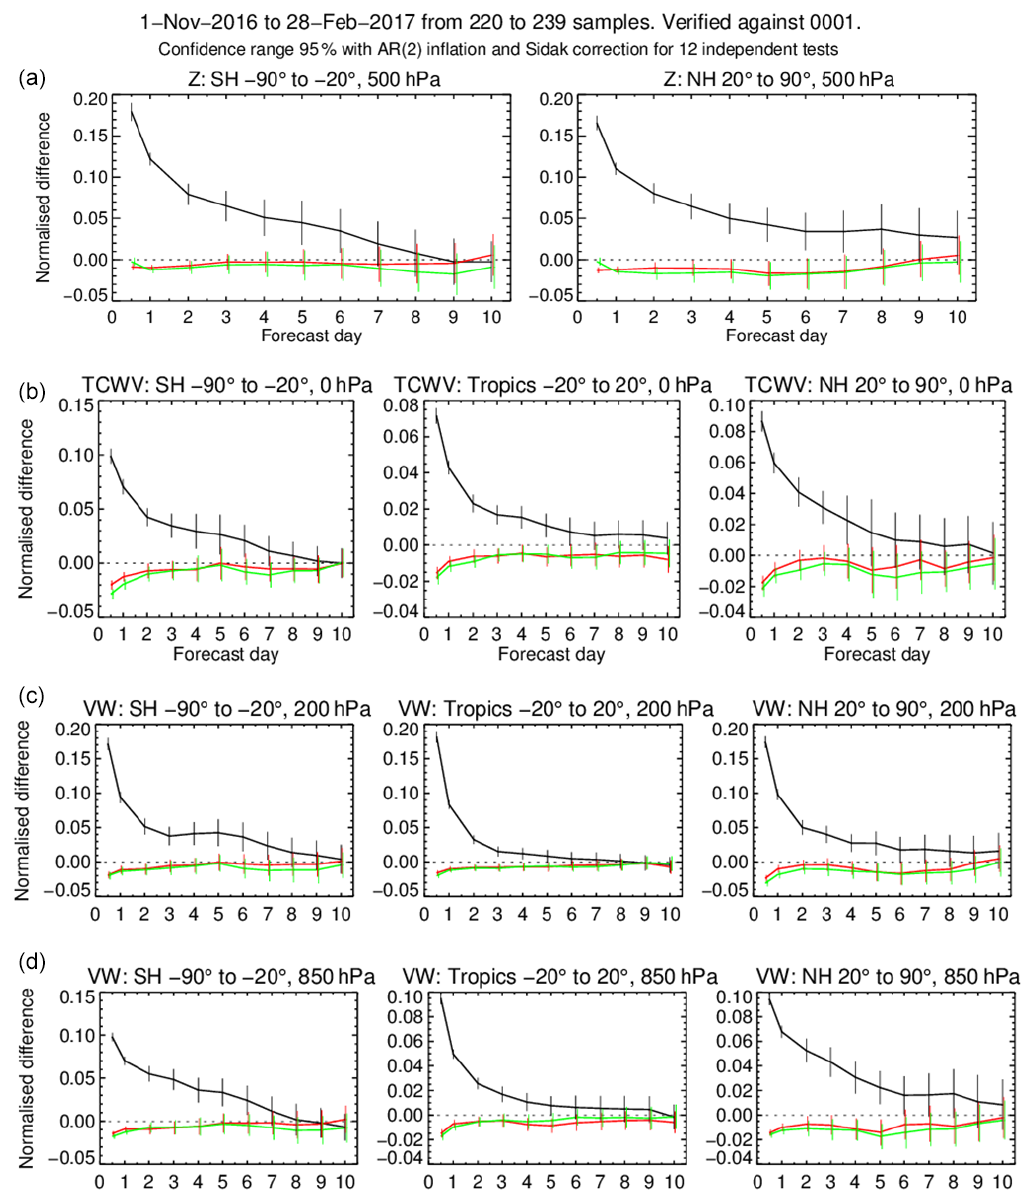
Figure 12. Normalised root mean square forecast errors for geopotential at 500hPa (a) ; total column water vapour (b) ; wind vector at 200hPa (c) ; wind vector at 850hPa (d) . The black/red/green lines refer to the one/four/five outer loop experiments, respectively. Errors are normalised with respect to the three outer loop experiments and are computed using the operational ECMWF analysis as verification. Error bars represent 95% confidence